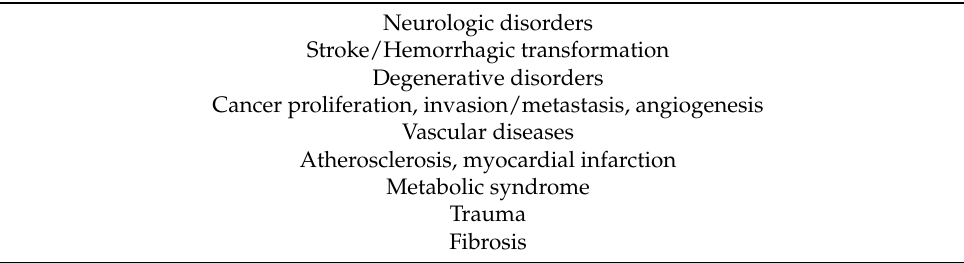
Table 2. Role of the fibrinolytic system in multiple disorders.